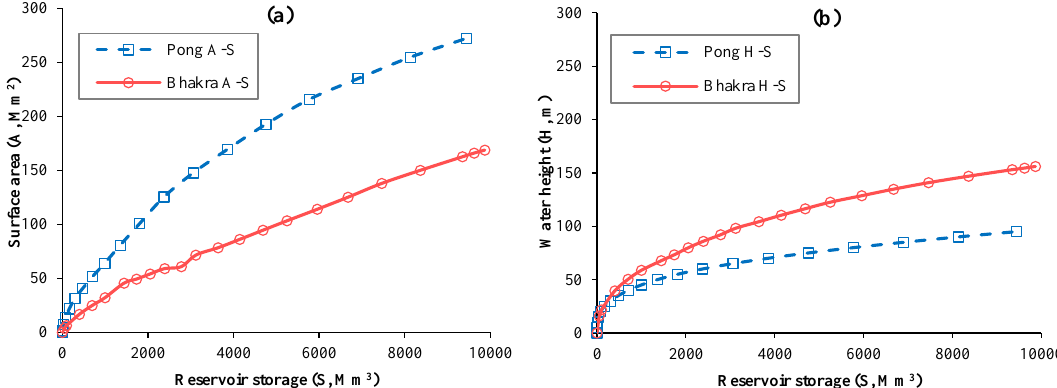
Figure 4. Plotted available topographical data for ( a ) Area–Storage and ( b ) Height–Storage at Pong and Bhakra Reservoirs.